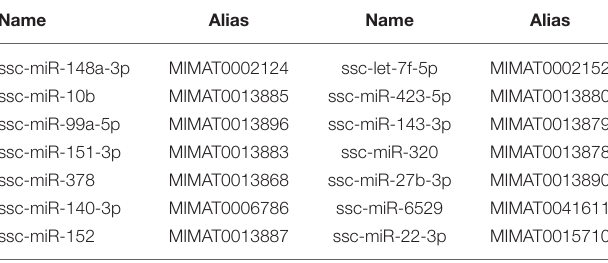
TABLE 2 | The list of 14 miRNAs with highest expressions among the 267 miRNAs found in isolated